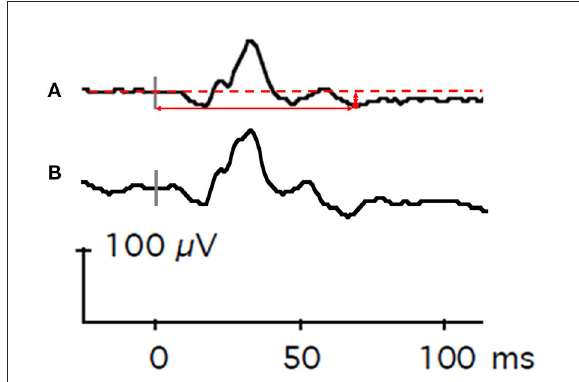
FIGURE2 Representative flash electroretinography waveforms. (A) This composite waveform was generated from Case Subject 101 by averaging 12 individual waveforms elicited by repeated presentations of a red light (4ms duration, 3.05 cd • s/m 2 ) against a static blue background (10.80 cd • s/m 2 ). The dashed horizontal red line is baseline voltage. The vertical gray bar indicates light onset. The red circle denotes the lowest voltage of the waveform after the B-wave. The vertical solid red arrow represents PhNR amplitude, and the horizontal solid red arrow represents PhNR peak time. (B) For comparison, a composite waveform generated from Control Subject 202. The vertical gray bar indicates light